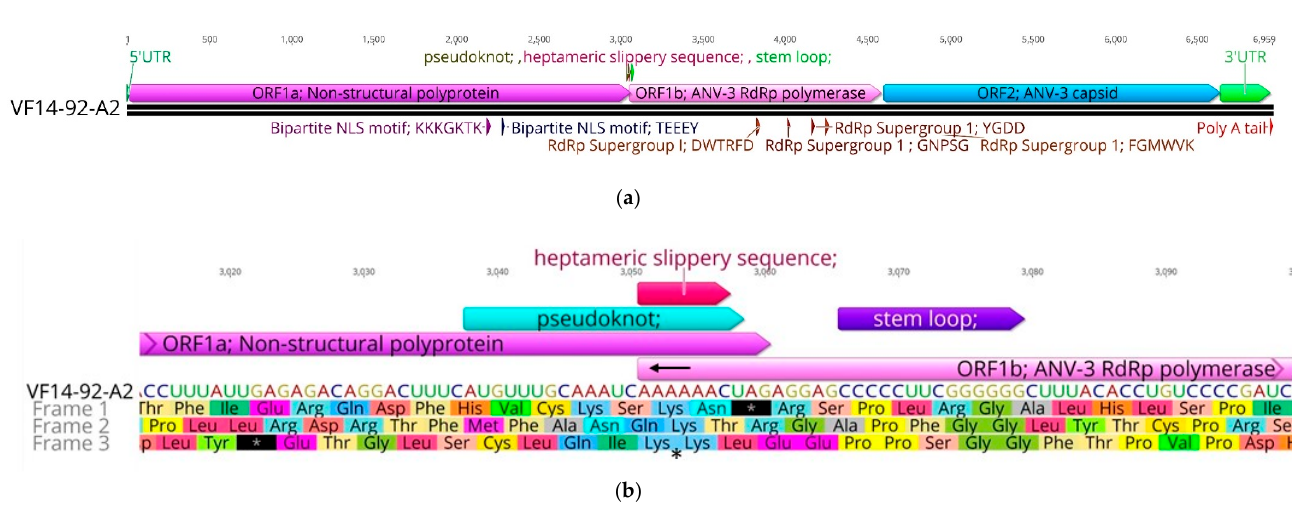
Figure 2. Astroviridae ribosomal frameshift mechanism ORF1a and ORF1b . Alignment of the Avastroviridae whole ge- nome heptameric slippery sequence and stemloop region including ANV-3 strains and MT585643 VF14-92-A2 and MT585644 VF16-03-164b. Red box is ANV VF14-92-A2 and VF16-03-64b, blue box and * identify the methionine/putative start codons, and the black box marks the heptameric slippery sequence.